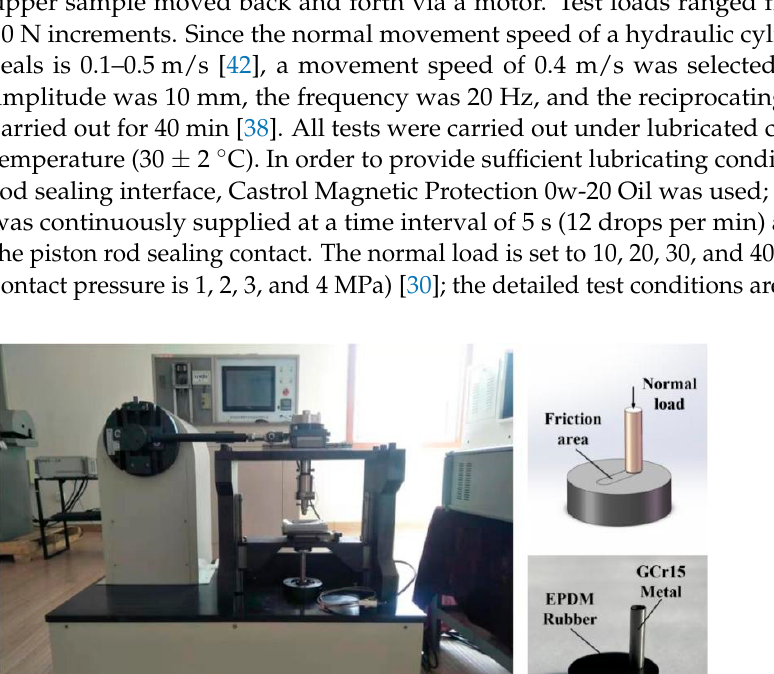
texture area density of 6.4%; ( b ) EPDM rubber surface with a texture area density of 6.4%.